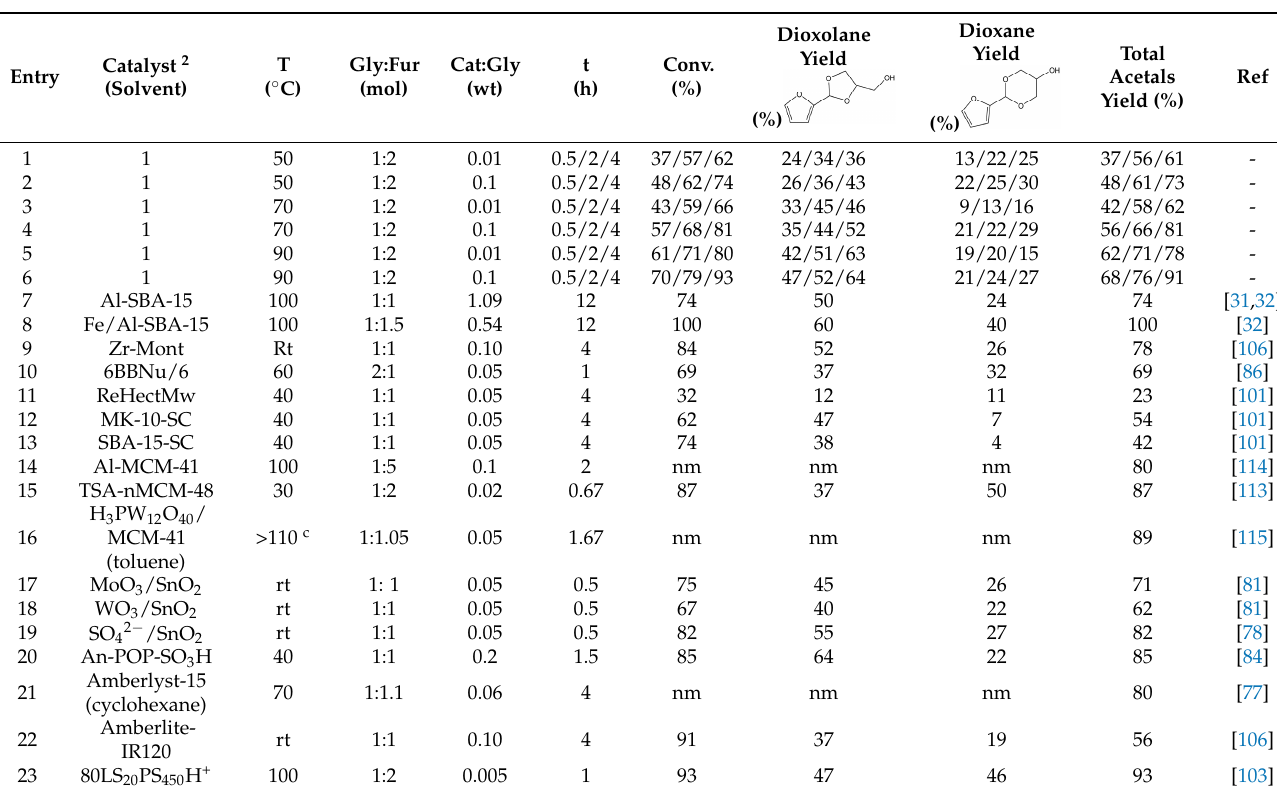
Table 3. Comparison of the results for 1 to literature data for other solid acid catalysts studied for the Fur/Gly reaction to heterobicyclic products 1 .